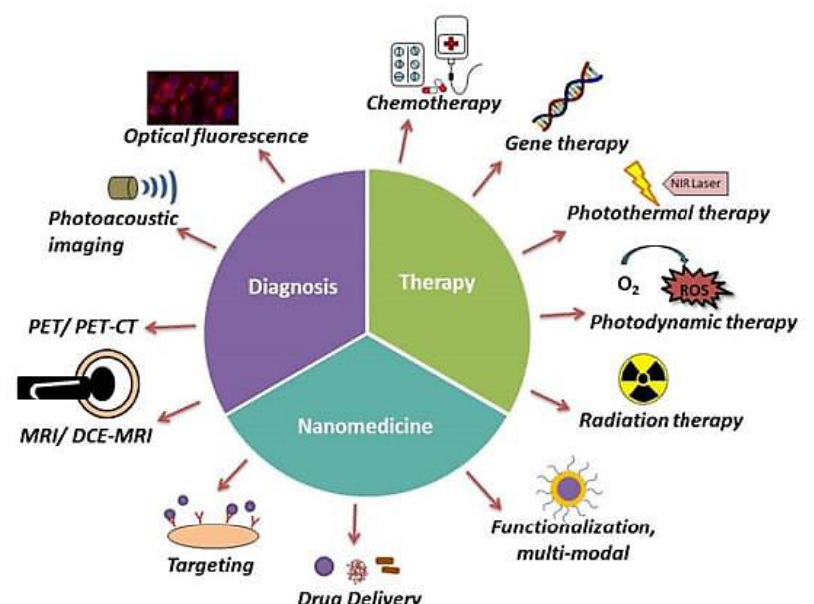
Figure 1. Current State of Breast Cancer Diagnosis, Treatment, and Theranostics. Adapted from [13] under CC BY license.